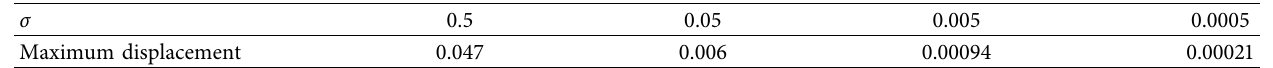
Figure 7: Controlled system behavior for different magnitudes of σ and λ � 1, η � 10. (a) (b) Table 2: Maximum displacement versus parameter of σ